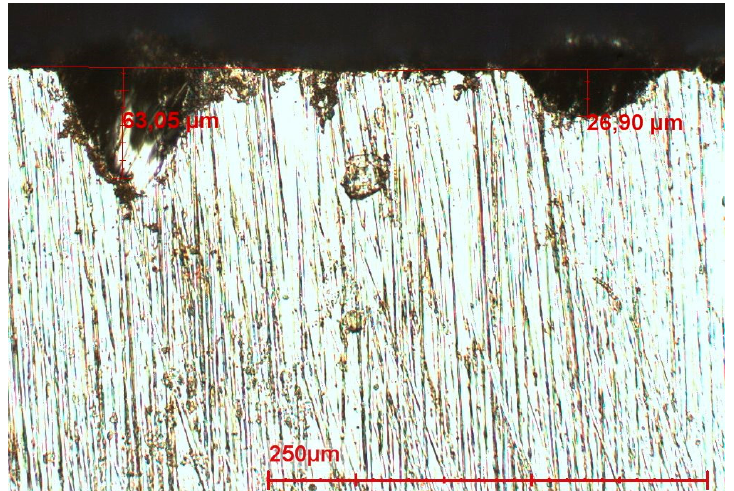
Figure 16. Cross-sectional view at two pits for sample B2 after exposure to the SW + bacteria for 28 days. The maximum pit depth is 63 µm.